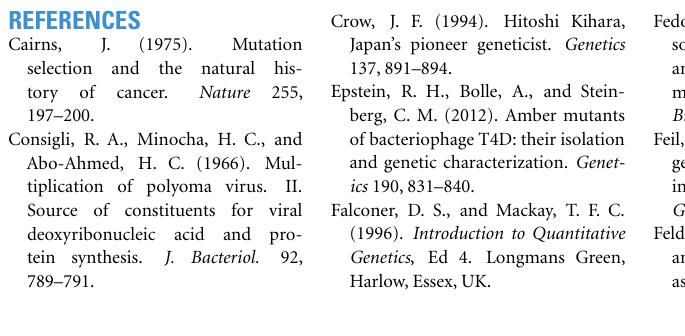
FIGURE 4 | Sister chromatid segregation in mitotic figures of T. aestivum : effects of varying the dosage of chromosomes 5B and 5D (data from Lark, 1969a, Figure 7). Histograms of the frequency of cells in which the indicated percentages of grains were observed in the less